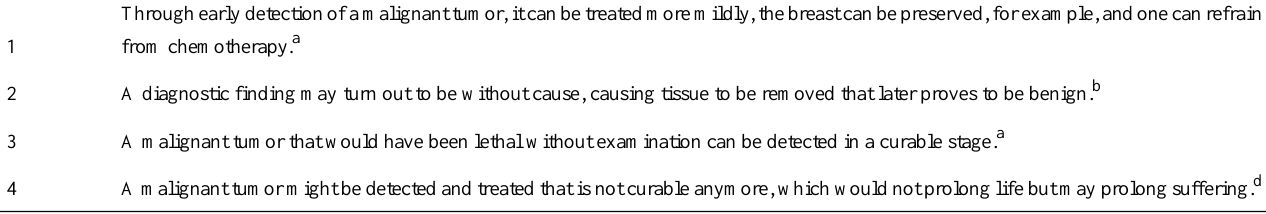
Table 5. Assessment of arguments about mammography